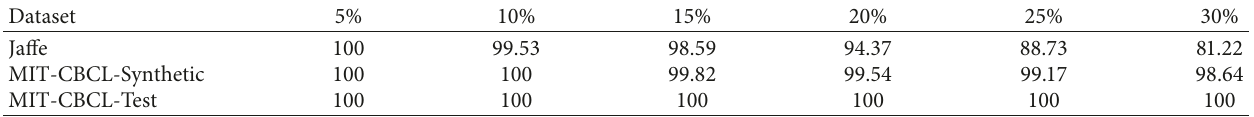
Table 2: Model assessment without imputation.